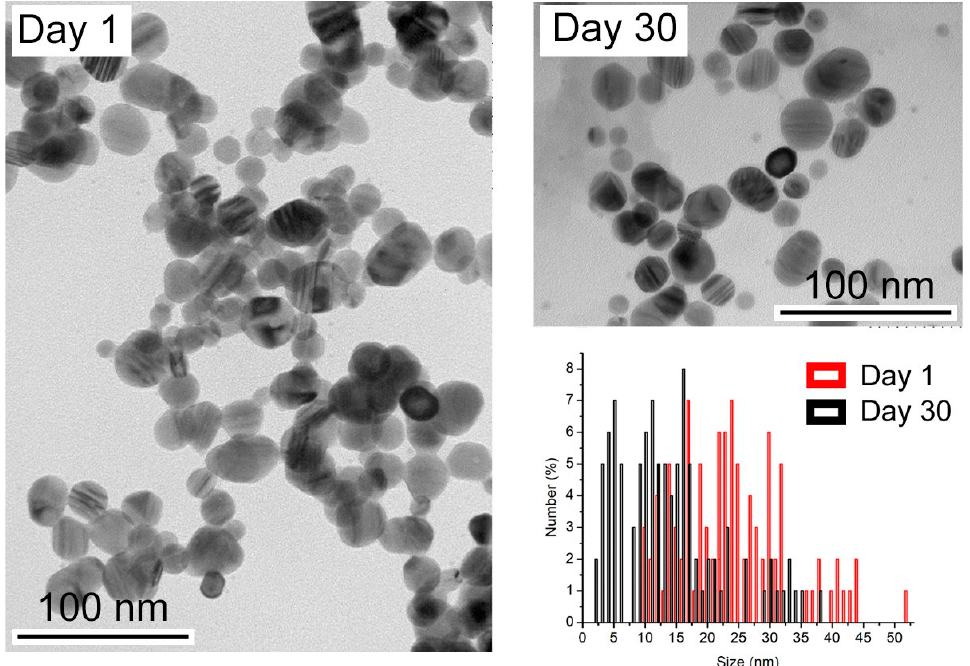
Figure 2. TEM images of the synthesized AgNPs and after 30 days. Size distribution of AgNPs calculated from TEM images.